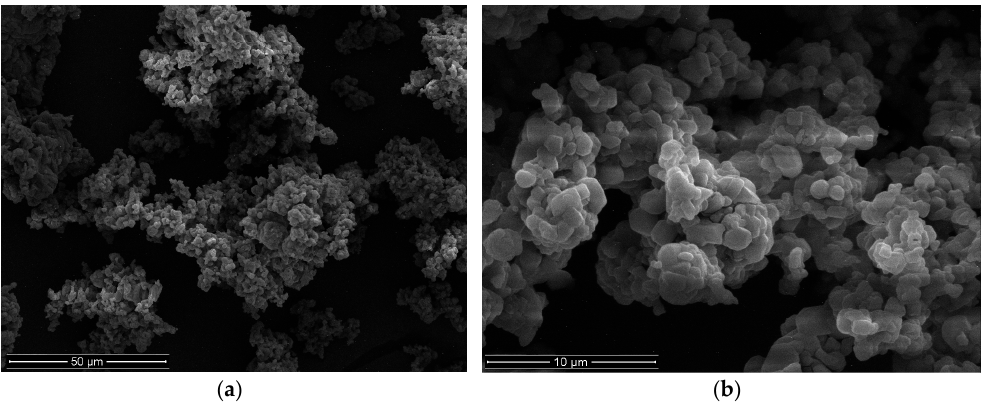
Figure 2. Images of microparticles CA1 ( a ) ×2000, ( b ) ×10000.